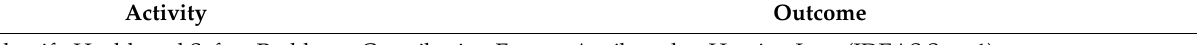
Table 2. Summary of selected IDEAS Toolkit Step results from HearWell Design Teams addressing hearing health at two transportation maintenance